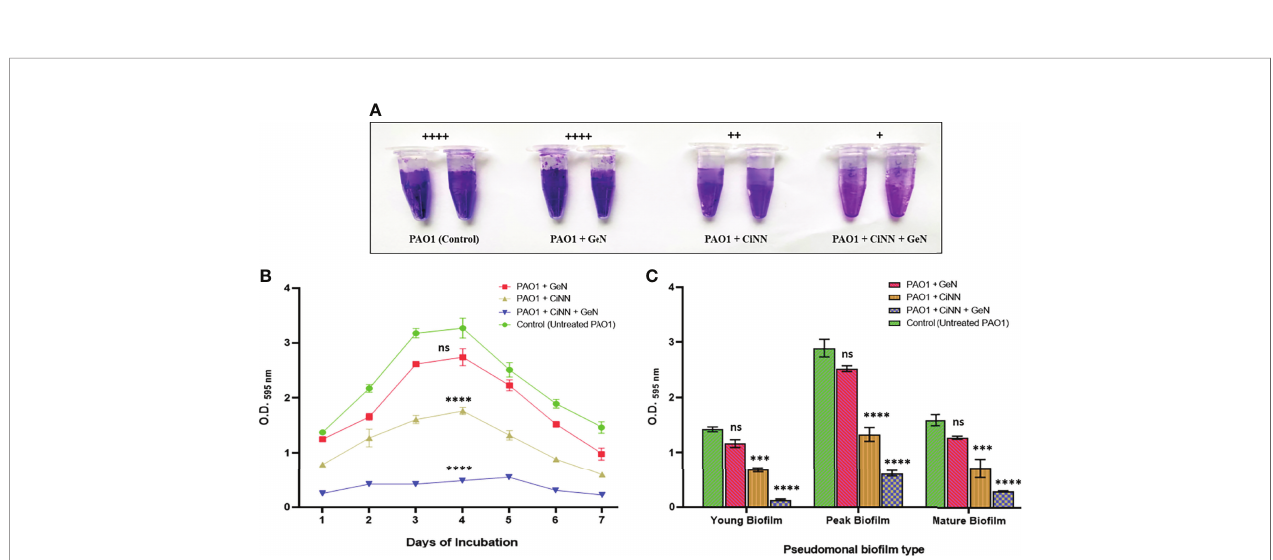
FIGURE 7 | Examining the anti-fouling effect of CiNN and GeN, alone and in combination against P. aeruginosa PAO1. (A) Qualitative bio fi lm formation assay in microcentrifuge tubes. Adherence scores have been mentioned above in each experimental group. (+): weak adherence, (++): moderate adherence, (+++): strong adherence, and (++++): very strong adherence. (B) Bio fi lm inhibition pattern of PAO1 in the presence and absence of CiNN and GeN obtained from quantitative CV assay. (C) Comparative analysis of eradication ability of CiNN and GeN, alone and in combination against preformed bio fi lms of PAO1 of different ages. (ns, not signi fi cant, ***p ≤ 0.001, ****p ≤ 0.0001).